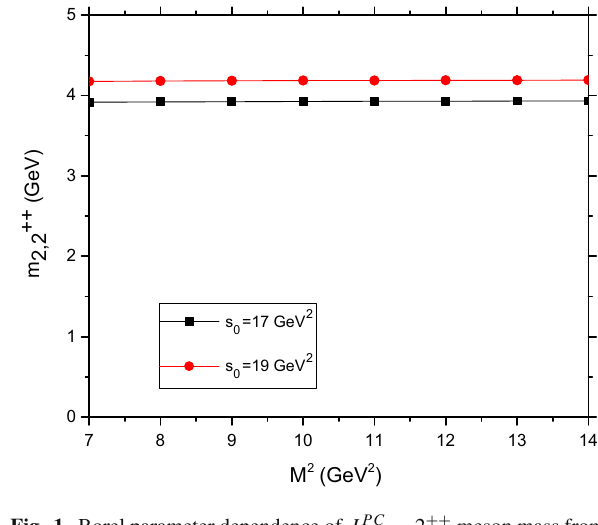
Fig. 1 Borel parameter dependence of J PC = 2 ++ meson mass from (cid:10) ( 2 ) μναβ for different s 0 values